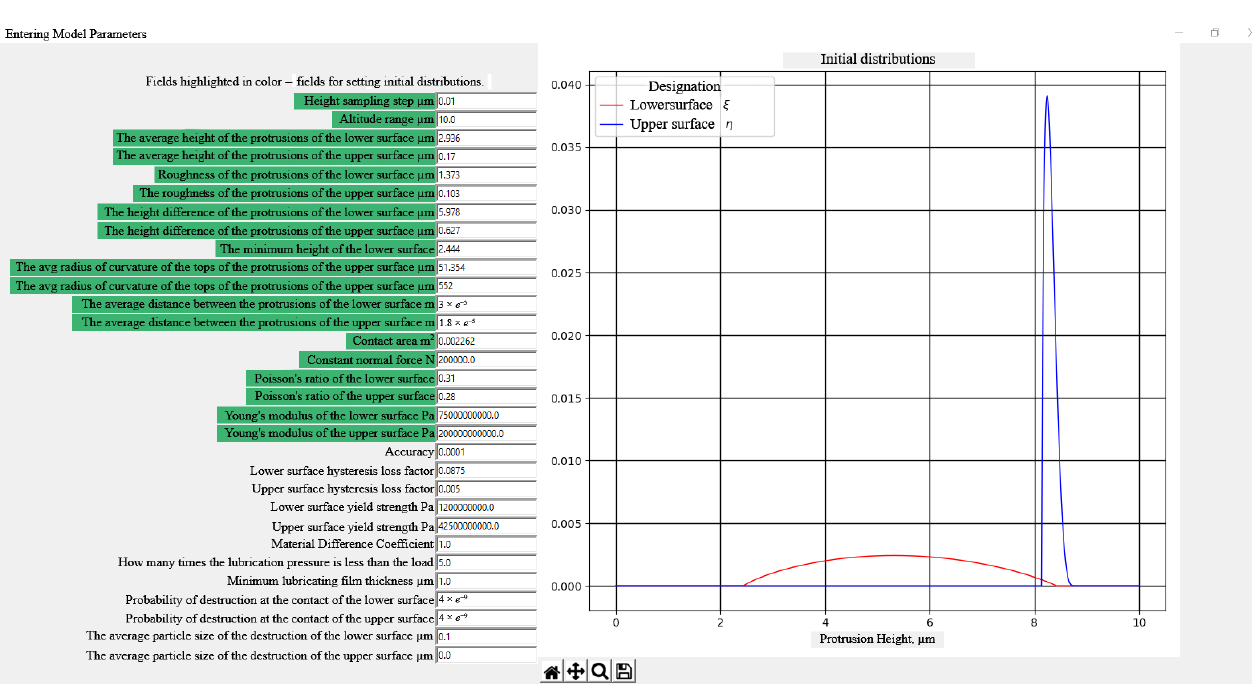
Figure A1. Program window with initial data input and height distribution.